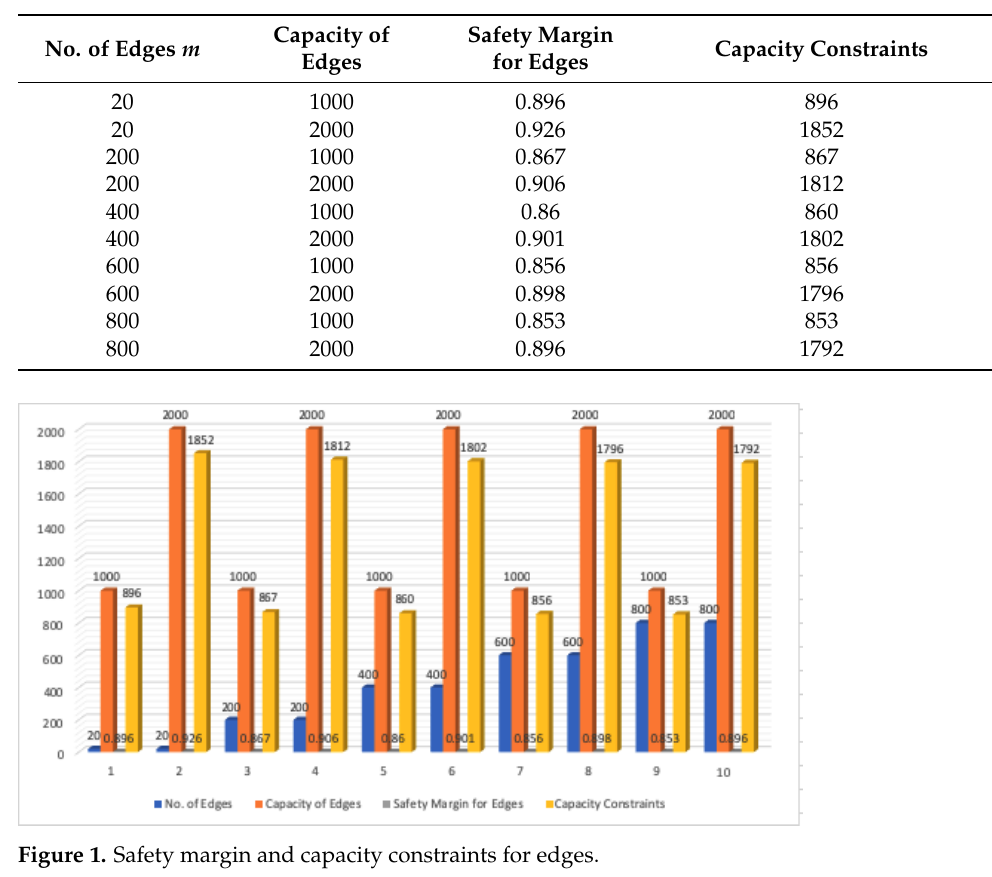
Table 2. Capacity constraints of edges with different safety margin.